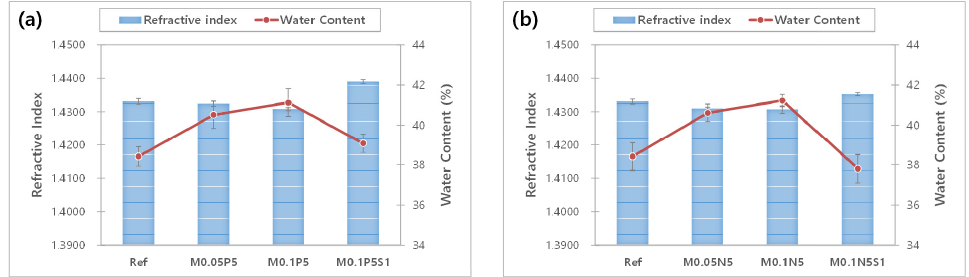
Figure 2. Change of refractive index and water content of samples. ( a ) PVP group; ( b ) NVP group.